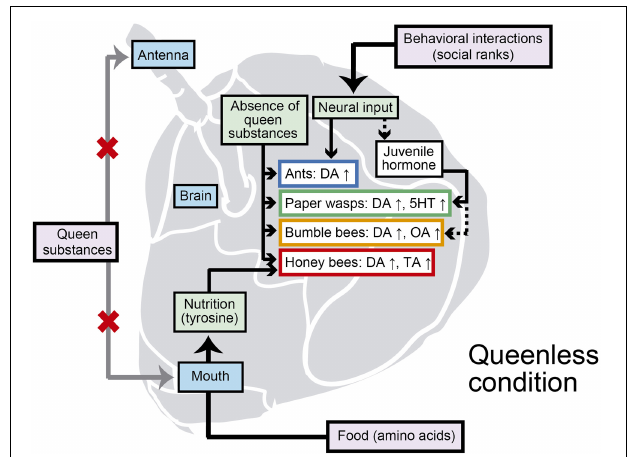
FIGURE 2 | Factors affecting increases in biogenic amines in the brain during the transition of non-reproductives to reproductives in Hymenoptera. Purple boxes indicate environmental factors. Dashed lines indicate hypothetical pathways. DA: dopamine, OA: octopamine, TA: tyramine, 5HT: serotonin. In this summary, “queen” and “queenless” are used in a broad sense to include functional queens in ants (i.e., gamergates).